Question: Sum up the contents of this chart in one sentence.
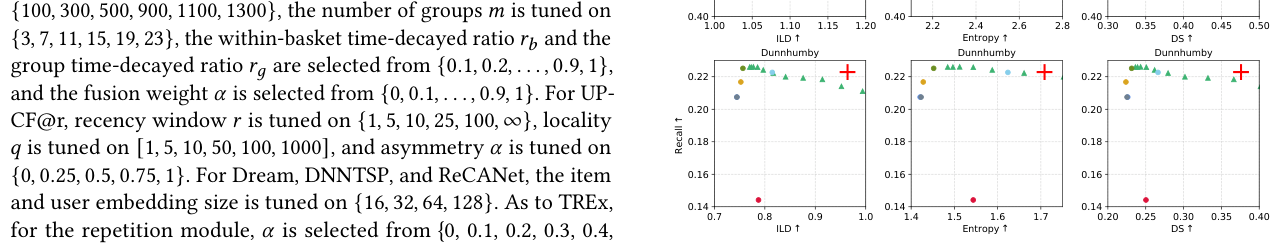
Answer: Performance of TREx𝐷𝑖𝑣𝑒𝑟𝑠𝑖𝑡𝑦at different 𝑣values, compared with different NBR methods in terms of different diversity metrics. The red + marker indicates the direction with both high accuracy and diversity.